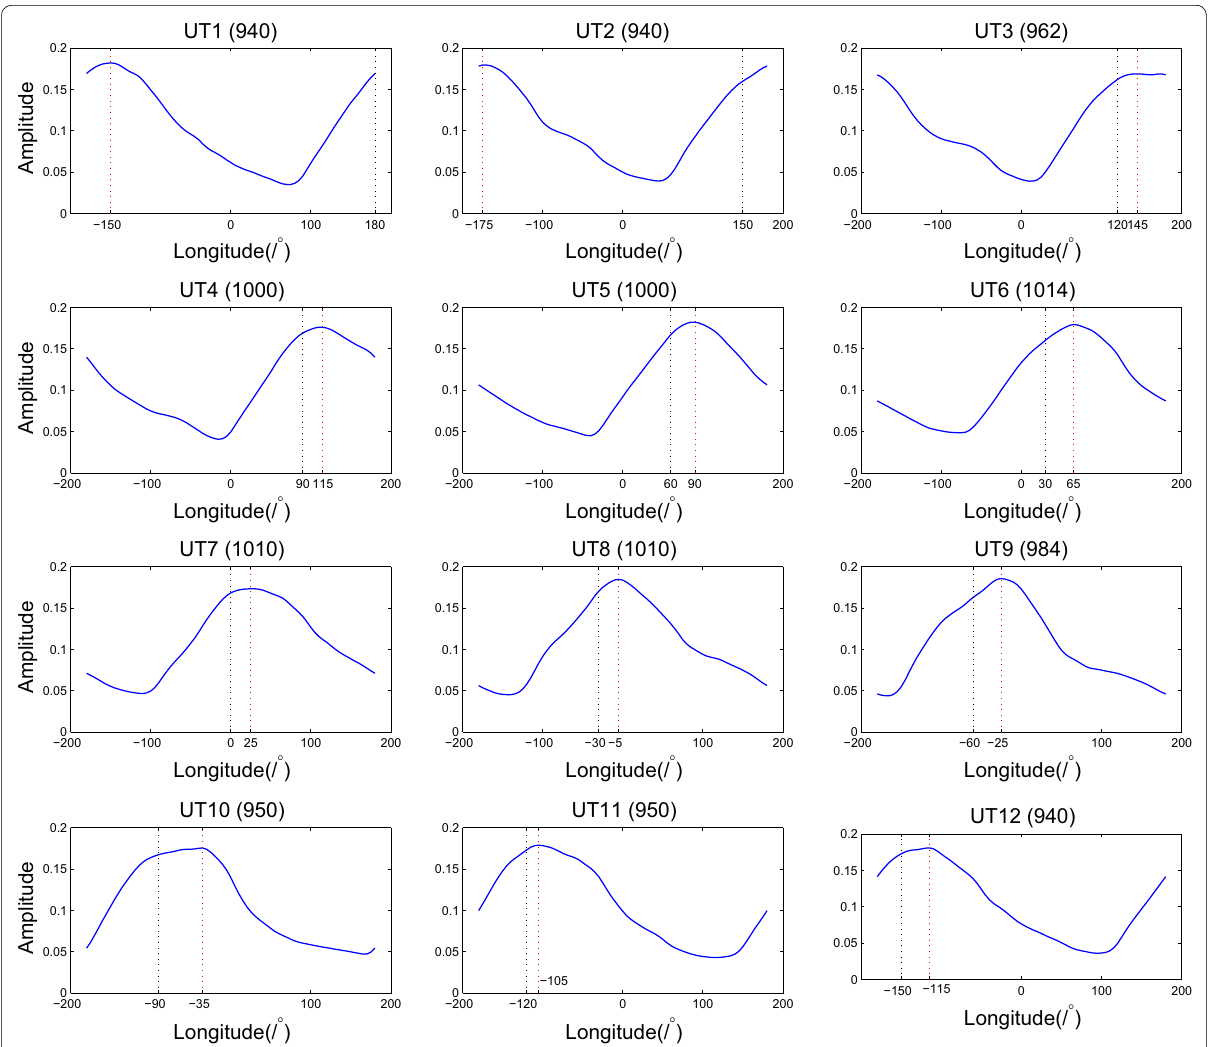
Fig. 8 Large-scale longitudinal variations in the ionosphere for the 12 UTs during the geomagnetic quiet time. The red dotted line indicates the longitude position of the maximum U ( 2 ) . The black dotted line indicates the longitude position of the maximum solar irradiation. The x-axis is the geographic longitude ranging from − 180 ◦ to 180